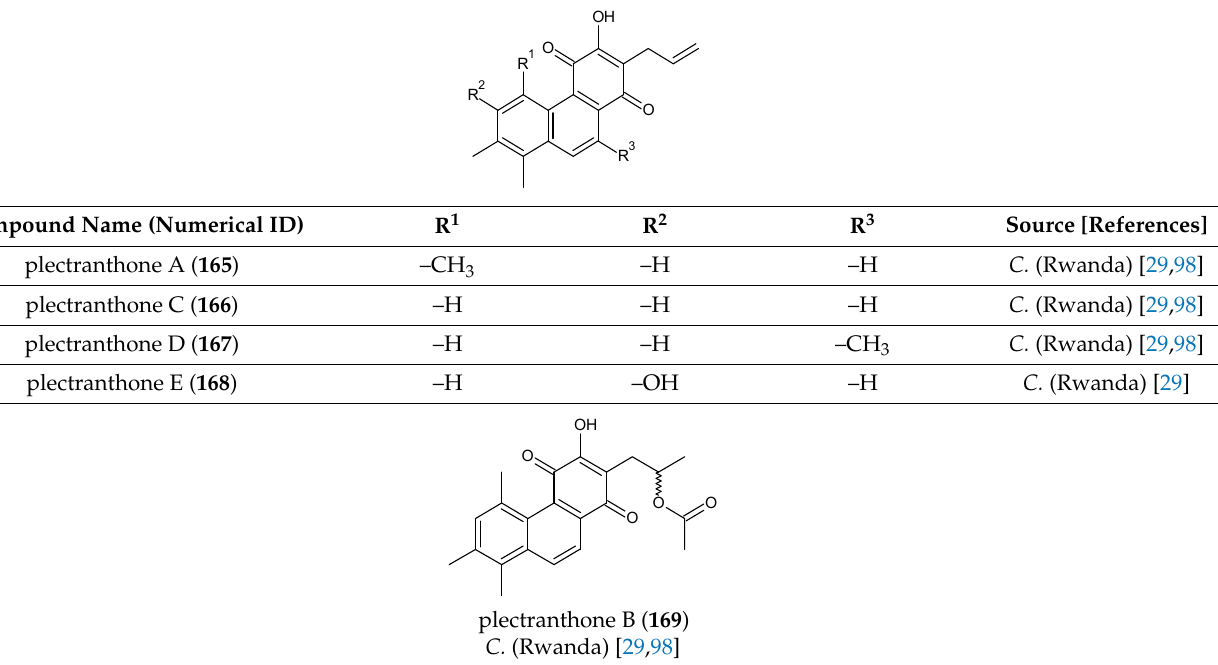
Table 5. Phenanthraquinones of the genus Plectranthus s.l.